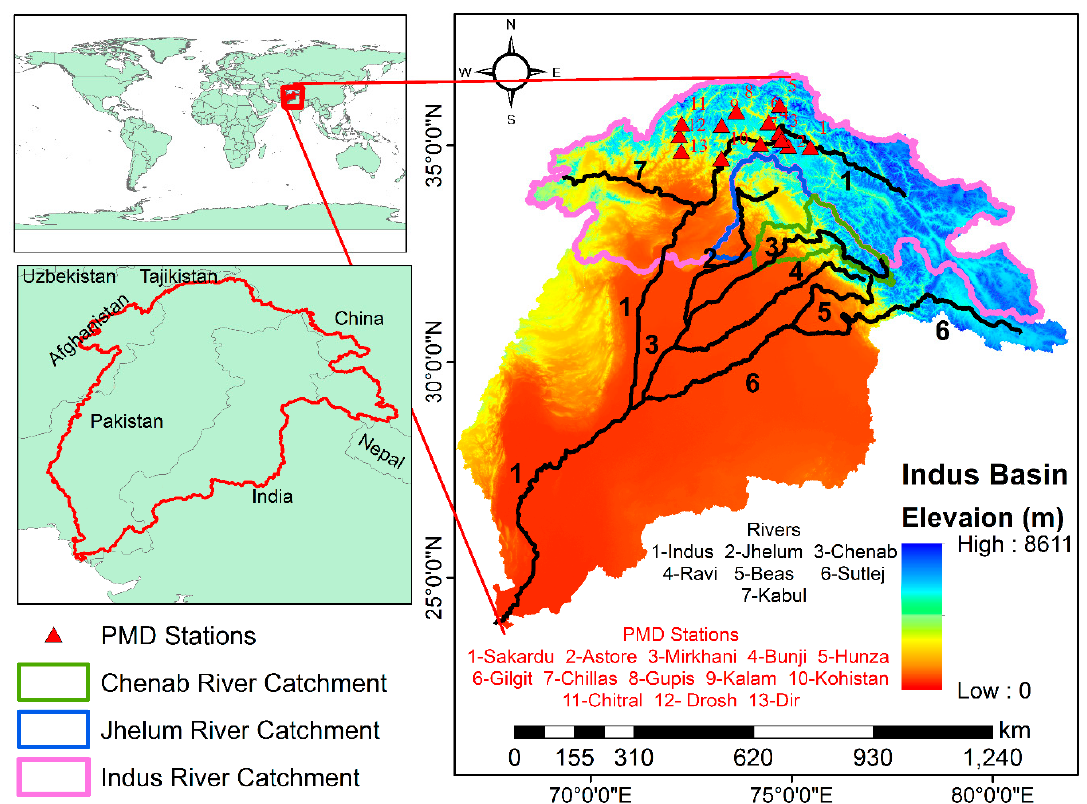
Figure 1. Topography of the transboundary Indus basin and its sub-catchments. Black lines, labeled from one to seven, are the rivers of the Indus basin. Red sites, labeled from one to 13, are the meteorological stations of Pakistan Meteorological Department for in situ snow data.